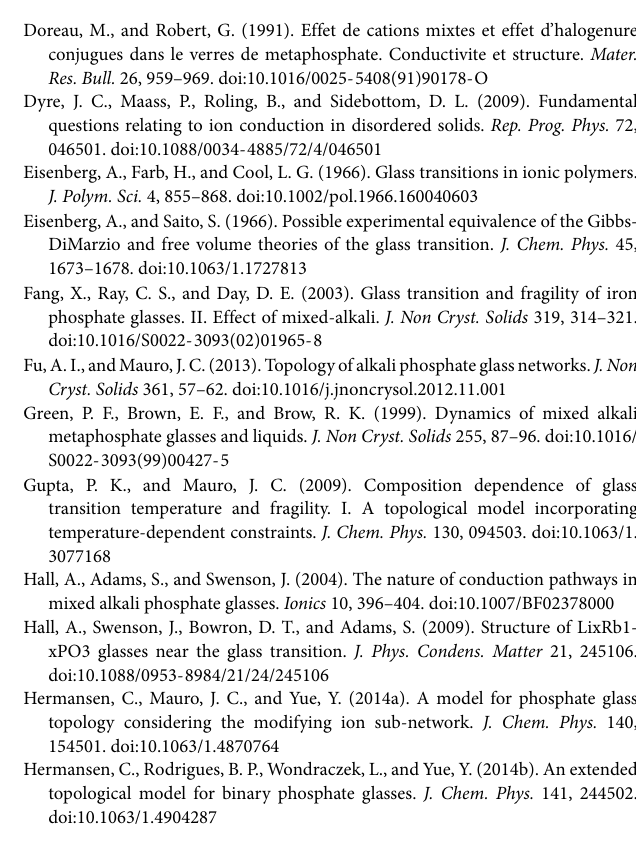
if they also depend on the pair of modifiers in question, meaning that the data points for mixed Na–R metaphosphate glasses would be shifted from the Li–R and so